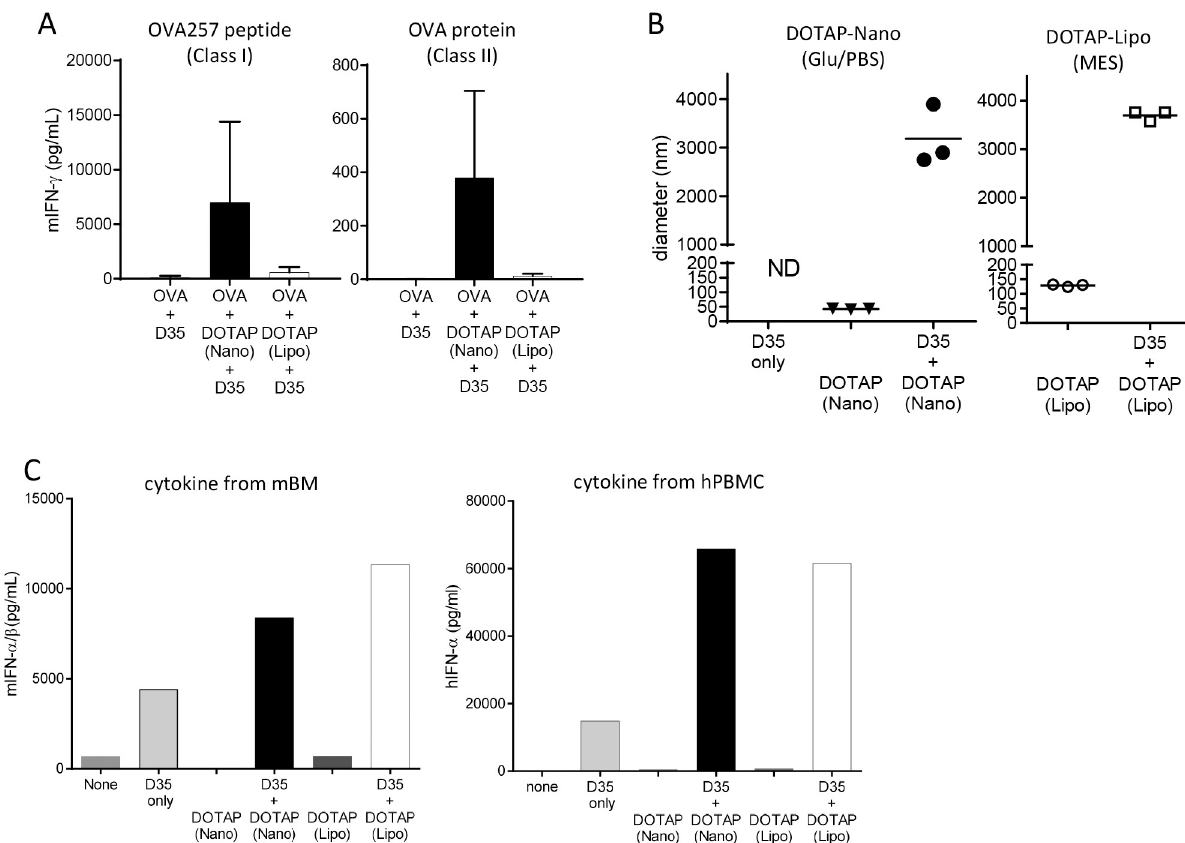
Fig 4. Antigen interaction is essential for the adjuvanticity of DOTAP-Nano plus D35. (A) C57BL/6J mice were immunized with OVA (10 μ g) and DOTAP (100 μ g) with D35 at the tail base. After seven days, splenocytes were collected and stimulated with OVA257-264 peptide and OVA protein. Twenty-four hours later, mouse IFN-gamma in the culture supernatant was measured by ELISA. The bar graph indicates the mean ± SD of three mice per group. (B) Particle size was measured by DLS. The sizes of D35 only, lipid particles only, and lipids mixed with D35 were measured under the indicated buffer conditions. An increase in particle size indicates that the particle interacts with D35. Each dot indicates one measurement. (C) Mouse BM (left panel) or human PBMCs (right panel) were incubated with D35 (6.3 μ g/mL) mixed with DOTAP-Nano or DOTAP-Lipo. DOTAP-Nano and DOTAP-Lipo only were also included as controls. Twenty-four hours later, the mouse IFN α / β concentration in the supernatant was measured by B16-Blue reporter cell assay. Human IFN- α concentration was measured by ELISA.